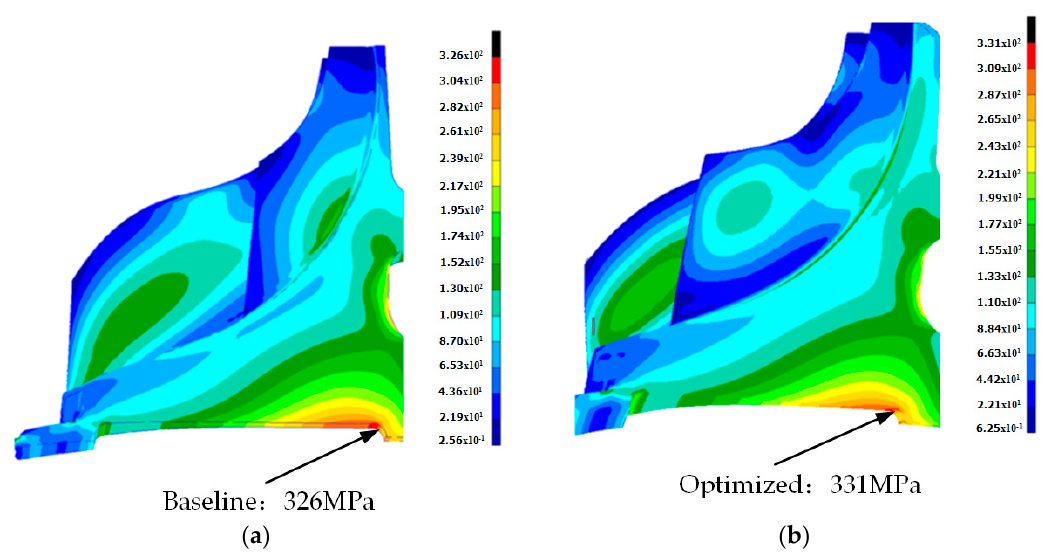
Figure 16. The von Mises stress distribution (units: MPa): ( a ) baseline; ( b ) optimized.